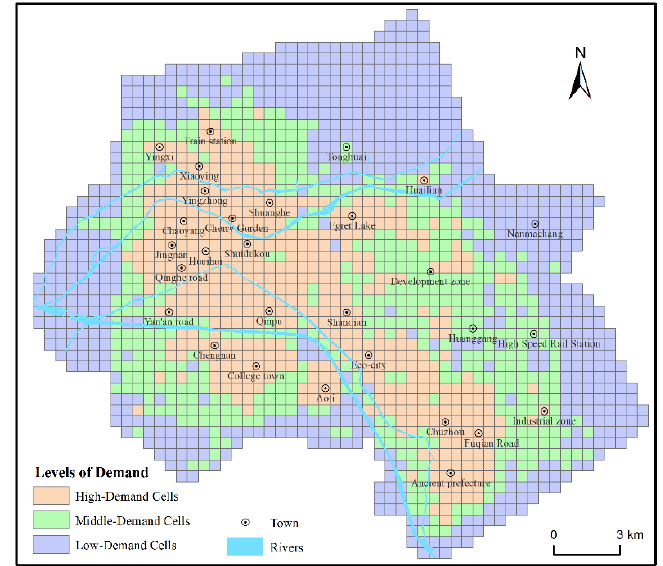
Figure 4. The spatial distribution of demand levels.